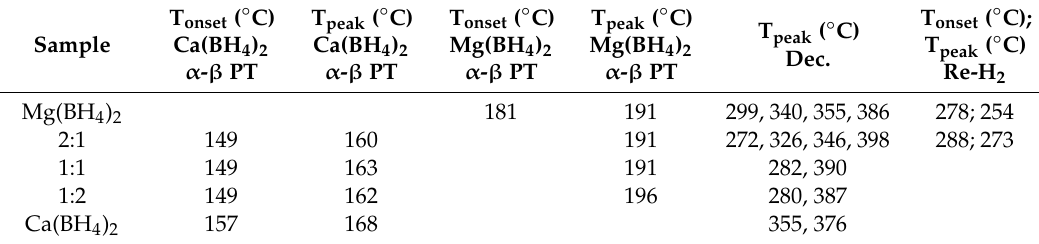
Table1. Onsetandpeaktemperaturesof α - β polymorphictransition,decomposition,andre-hydrogenation of pure Mg(BH 4 ) 2 , Ca(BH 4 ) 2 and their mixtures (2:1, 1:1, 1:2 molar ratio), obtained in the DSC analysis under 2 bar of H 2 reported in Figures 3 and 5. PT = phase transition; Dec. = thermal decomposition; Re-H 2 = rehydrogenation.